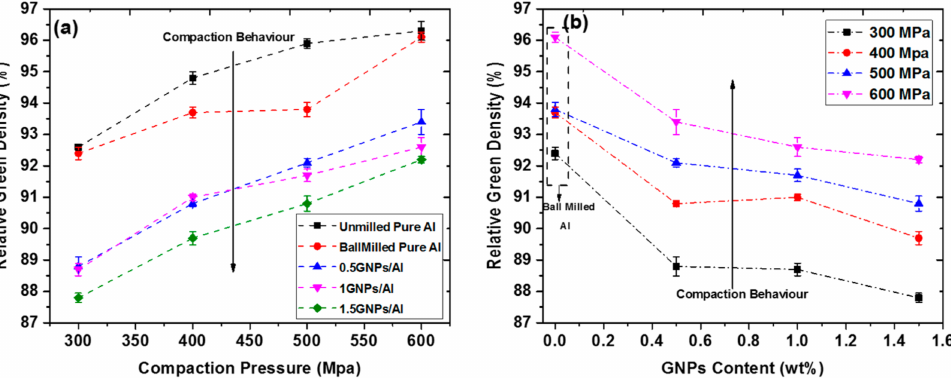
Figure 13. Effect of compaction pressure ( a ) and GNPs content ( b ) on relative green density (%) of pure and GNPs/Al composite